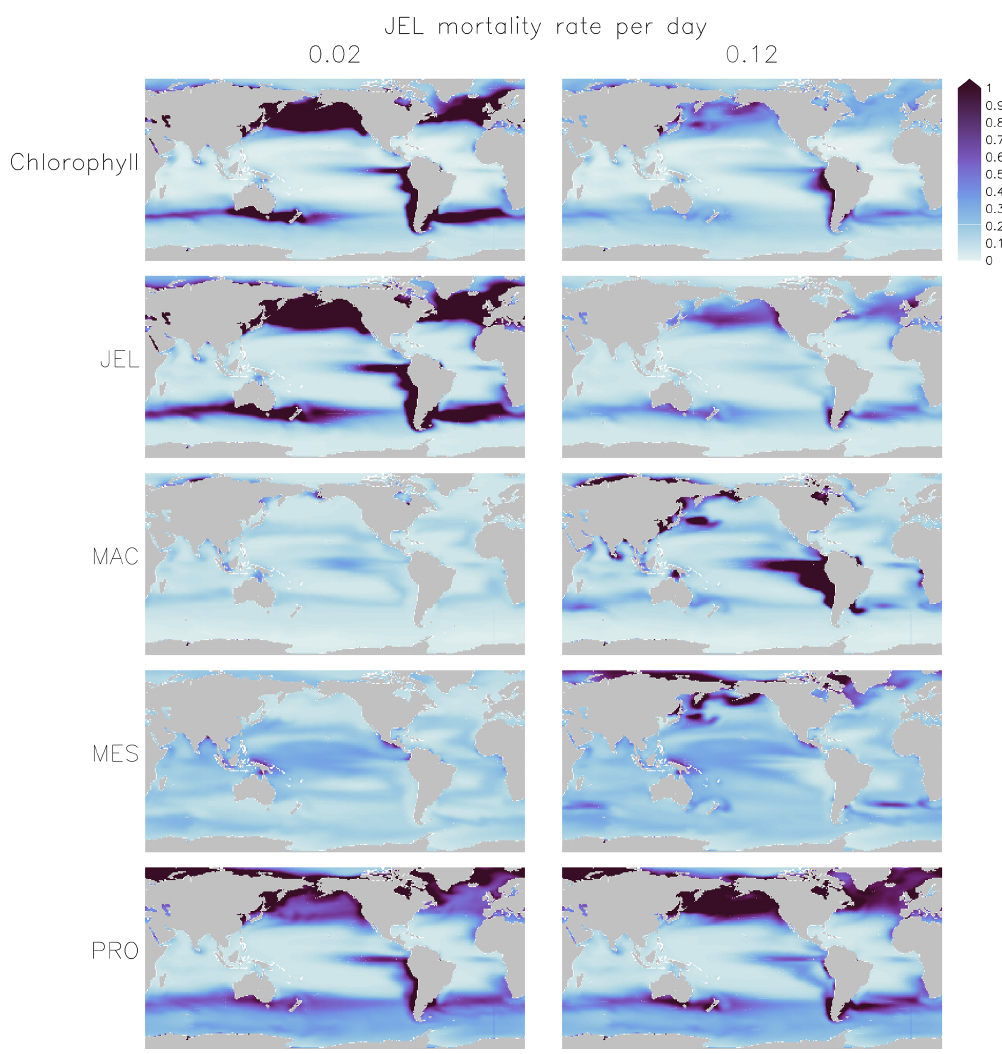
Figure 5. Annual mean surface chlorophyll (µgchlL − 1 ) and zooplankton carbon biomasses (µmolCL − 1 ) of JEL, MAC, MES and PRO for adjustment of JEL mortality for the simulation with a 0.02 mortality rate per day (left) and the adjusted fit simulation with a 0.12 mortality rate per day (right) used in PlankTOM11. Results are shown for the surface box (0–10m) and averaged for 1985–2015. Table 5. Changes to non-jellyfish PFT parameters across the PlankTOM simulations. PlankTOM10 LQ16 is the latest published version of PlankTOM with 10 PFTs (Le Quéré et al., 2016), while PlankTOM10 is the simulation from this